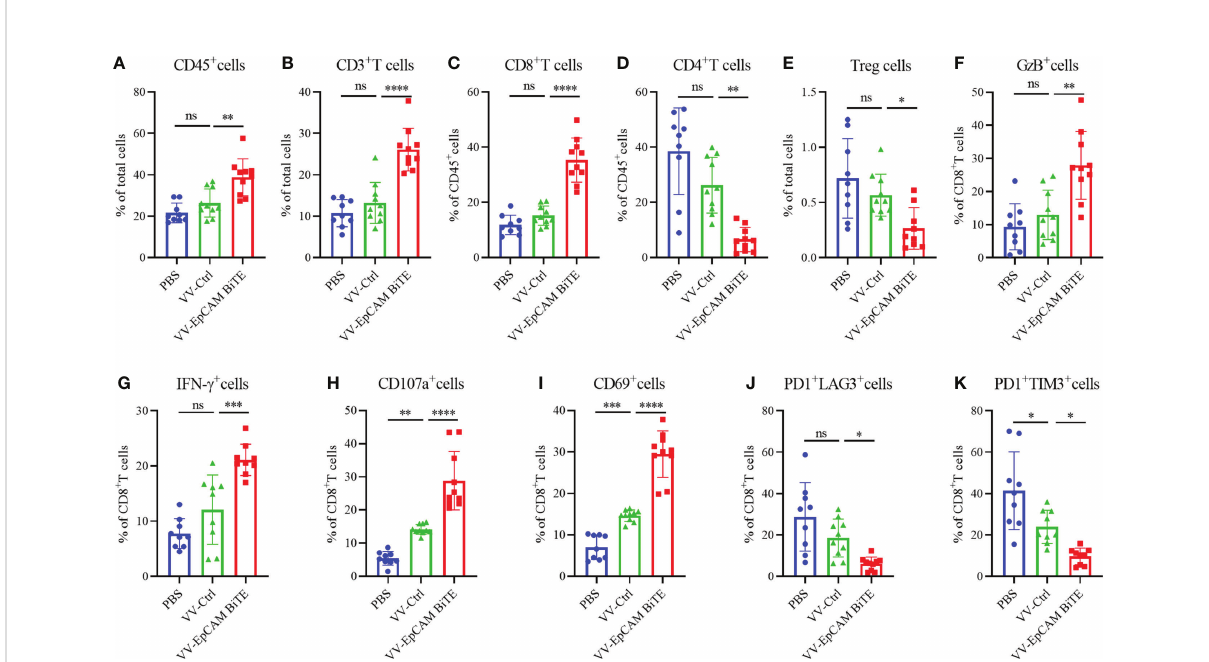
FIGURE 4 Immune cell in fi ltration of 4T1 model. (A-K) Preparation of single cell suspensions from digested tumor tissue as previously described in Materials and Methods. Flow cytometry analysis of the proportion of CD45 + cells (A) , CD3 + T cells (B) , CD8 + T cells (C) , CD4 + T cells (D) , Treg cells (E) , GzB + cells (F) , IFN- g + cells (G) , CD107a + cells (H) , CD69 + cells (I) , PD1 + LAG3 + cells (J) , and PD1 + TIM3 + cells (K) . Data are presented as the means±SD (n=9-10). ns, no signi fi cant differences; *p < 0.05; **p < 0.01;***p < 0.001; ****p <